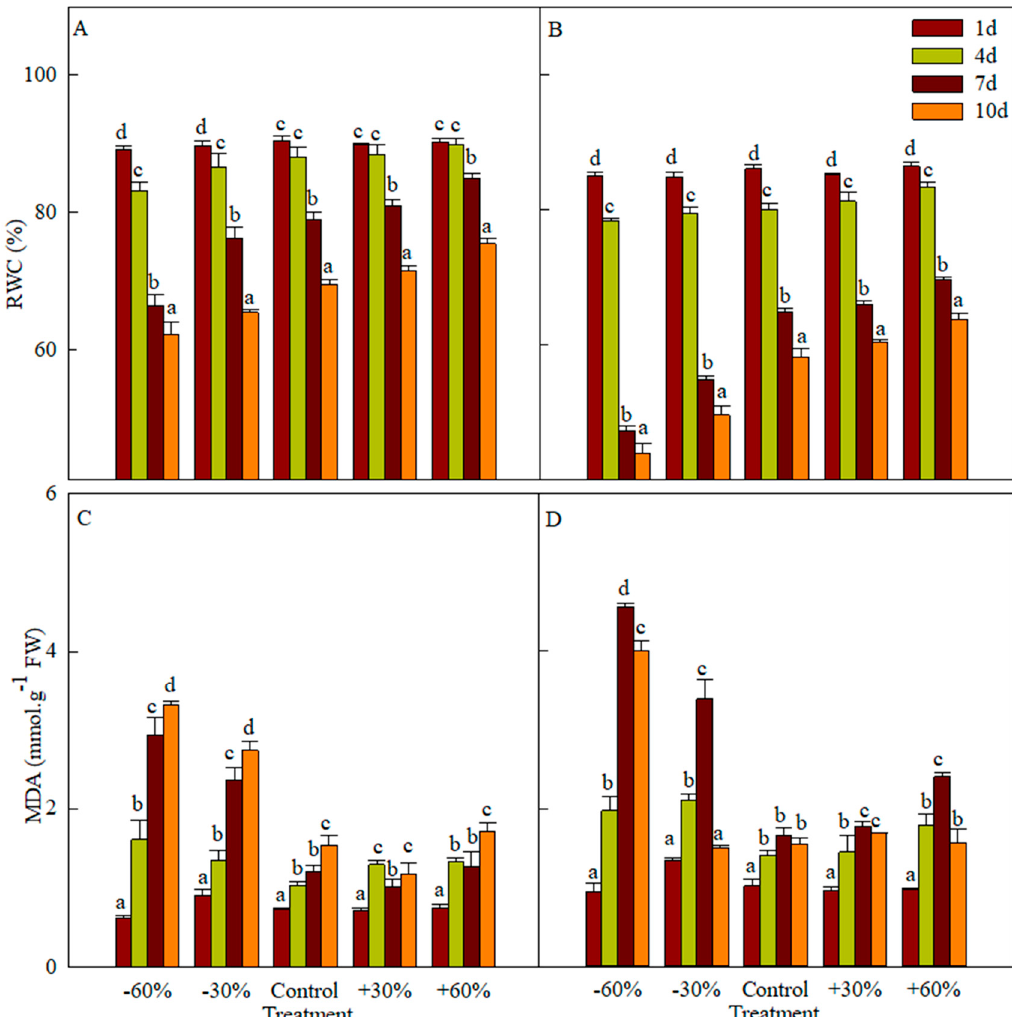
Figure 3. Influence of different precipitation treatments on relative water content (RWC) in T. terrestris ( A ), B. dasyphylla ( B ) and malondialdehyde (MDA) of T. terrestris ( C ), B. dasyphylla ( D ). Values are assigned as the mean ± SD.